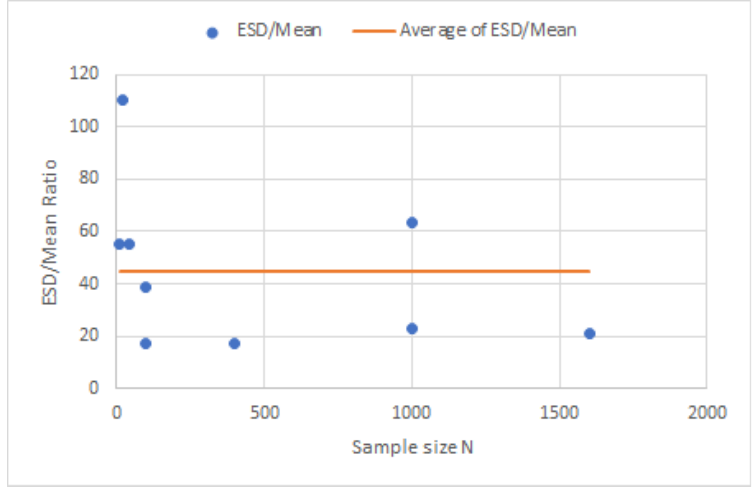
Figure 15. Ratio of standard deviation to many variation values of the means.